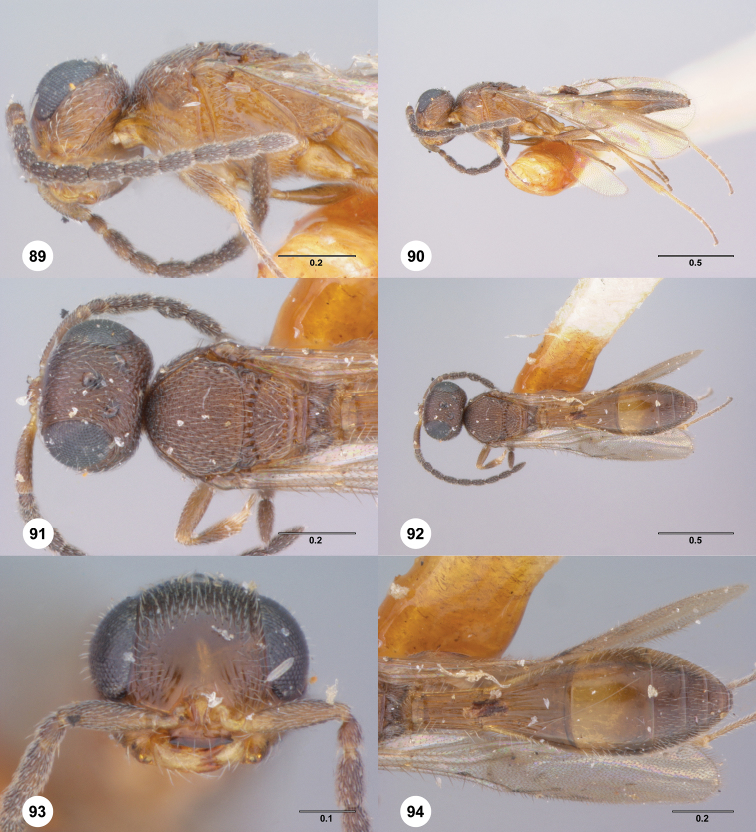
99
Probaryconus opacus (Kieffer), male holotype (CAS Type No. 9711) 89 Head and mesosoma, lateral view 90 Lateral habitus 91 Head and mesosoma, dorsal view 92 Dorsal habitus 93 Head, anterior view 94 Metasoma, dorsal view